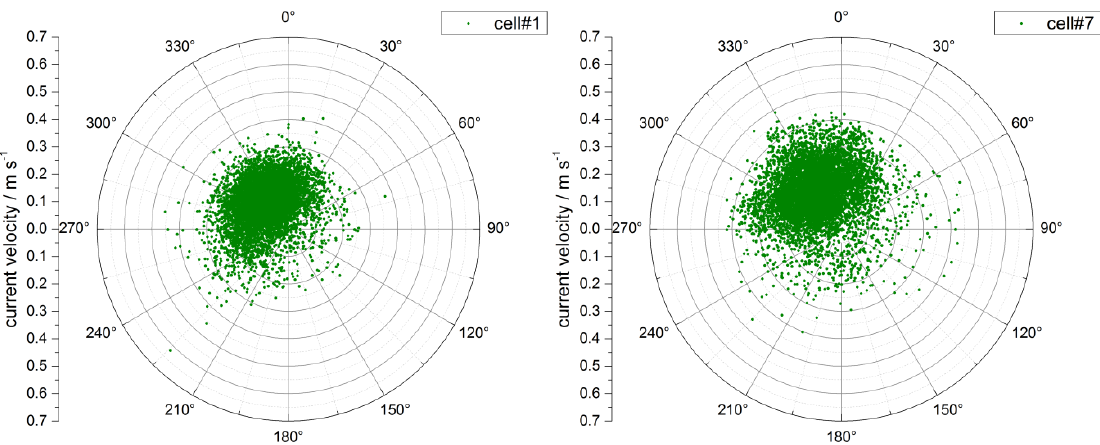
Figure 12. Corrected modules and directions of the currents measured by the ADCP in two cells of the profile.